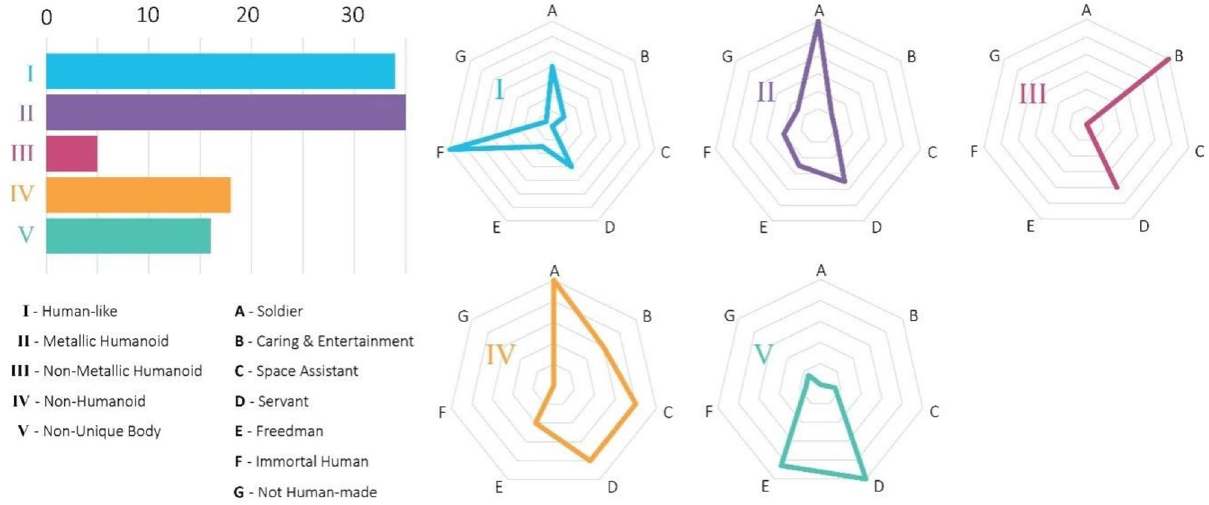
Fig. 3 Rader chart of the studied fictional robots’ appearance including the number of robots and the distribution of their roles in each cat-